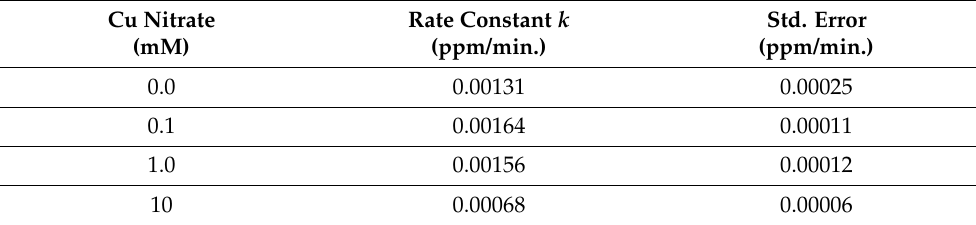
Figure 15. Action and absorption spectrum of Cu-TiO 2 prepared with 10.0 mM of Cu nitrate. Ther- mal treatment under nitrogen for 1 h was performed after synthesis. Inset shows photograph of doped sample.